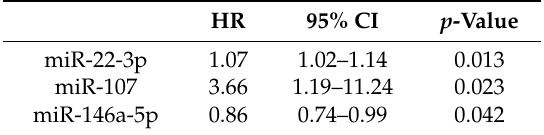
Table 2. Crude risk of major adverse cardiovascular events (MACE) according to